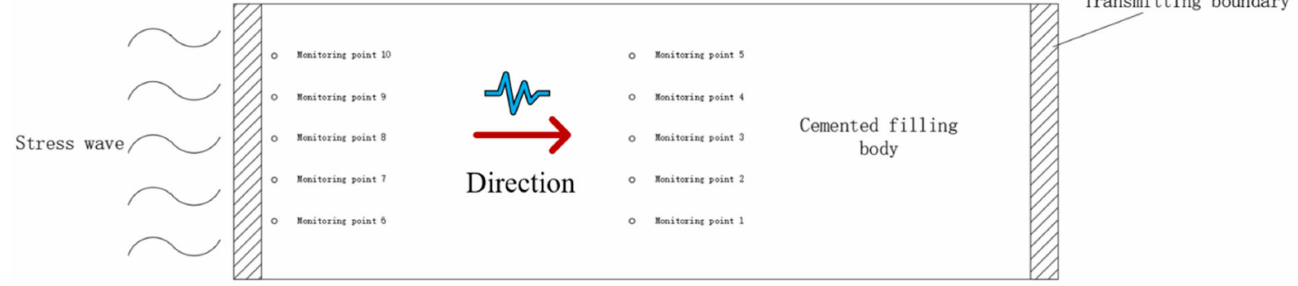
Figure 13. Model diagram.